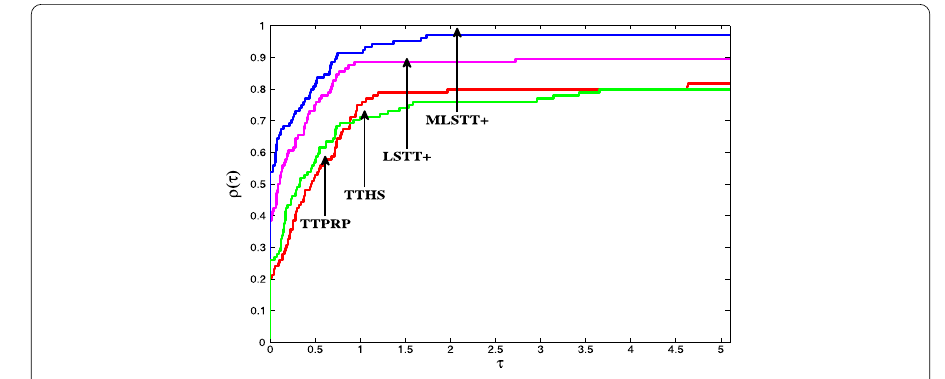
Figure 4 Performance profiles on Tcpu of four CG methods